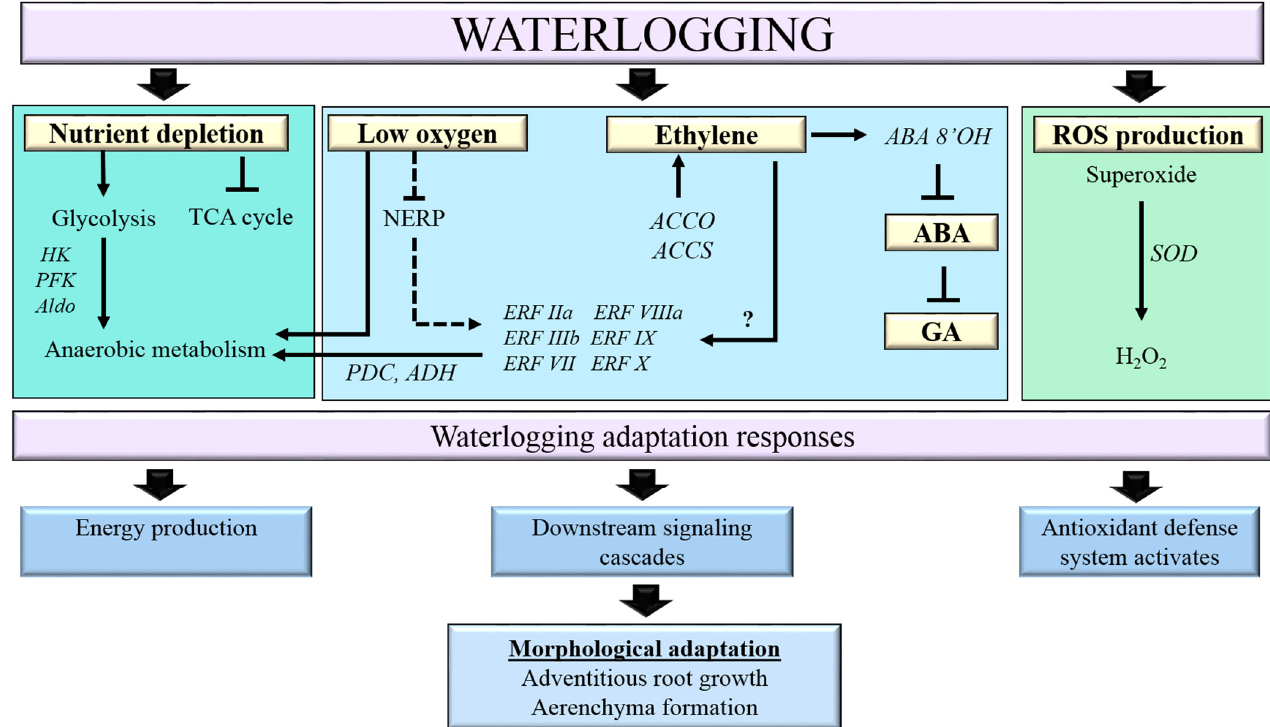
Figure 10. The proposed model of the pathways involved in Musa acuminata under waterlogging stress. Arrows indicate the activation of the pathway, while blunt end arrows indicate inhibition of the pathway. The dashed line indicates partial activation of the NERP pathway, leading to the par- tial inhibition of ERFVII TFs. The question mark indicates an unknown EIN3/EIL independent